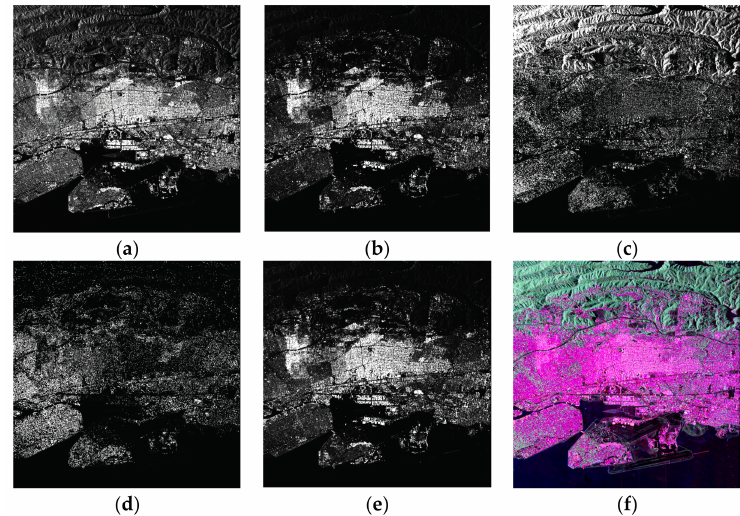
Figure 10. Decomposition results of UAVSAR data: ( a – d ) surface, double-bounce, volume, and oriented dihedral scattering powers, respectively; ( e ) urban scattering power; and ( f ) color-coded decomposition result (blue, surface scattering; red, urban scattering; and green, volume